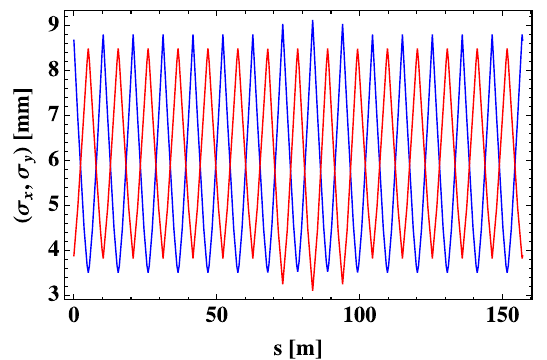
FIG. 12. One rms beam envelope for the 15-cell FODO lattice with a working point of Q x =Q y ¼ 4 . 28 = 3 . 55 and a onefold symmetry. The optics are matched keeping the variation of the beam size as small as possible. The beam envelope has been calculated using the design transverse normalized emittance of 2 . 5 μ m and the rms momentum spread corresponding to the design longitudinal emittance of 2.8 eVs.